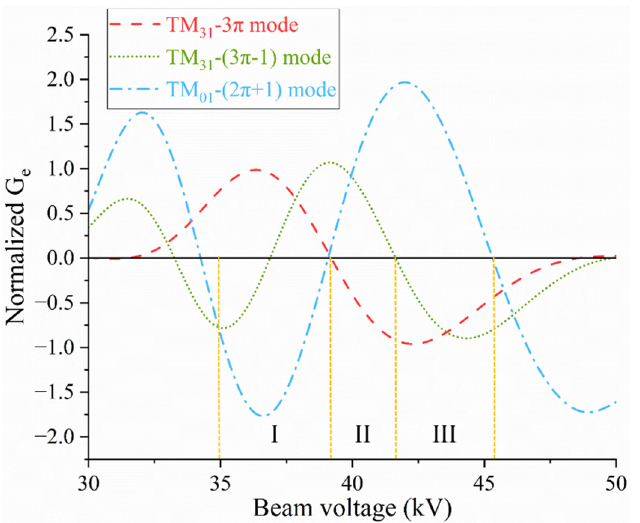
Figure 6. Normalized G e as a function of beam voltage for the TM 31 -3 π , TM 31 -(3 π − 1), and TM 01 -(2 π + 1) modes in the multiple sheet beam EIO.